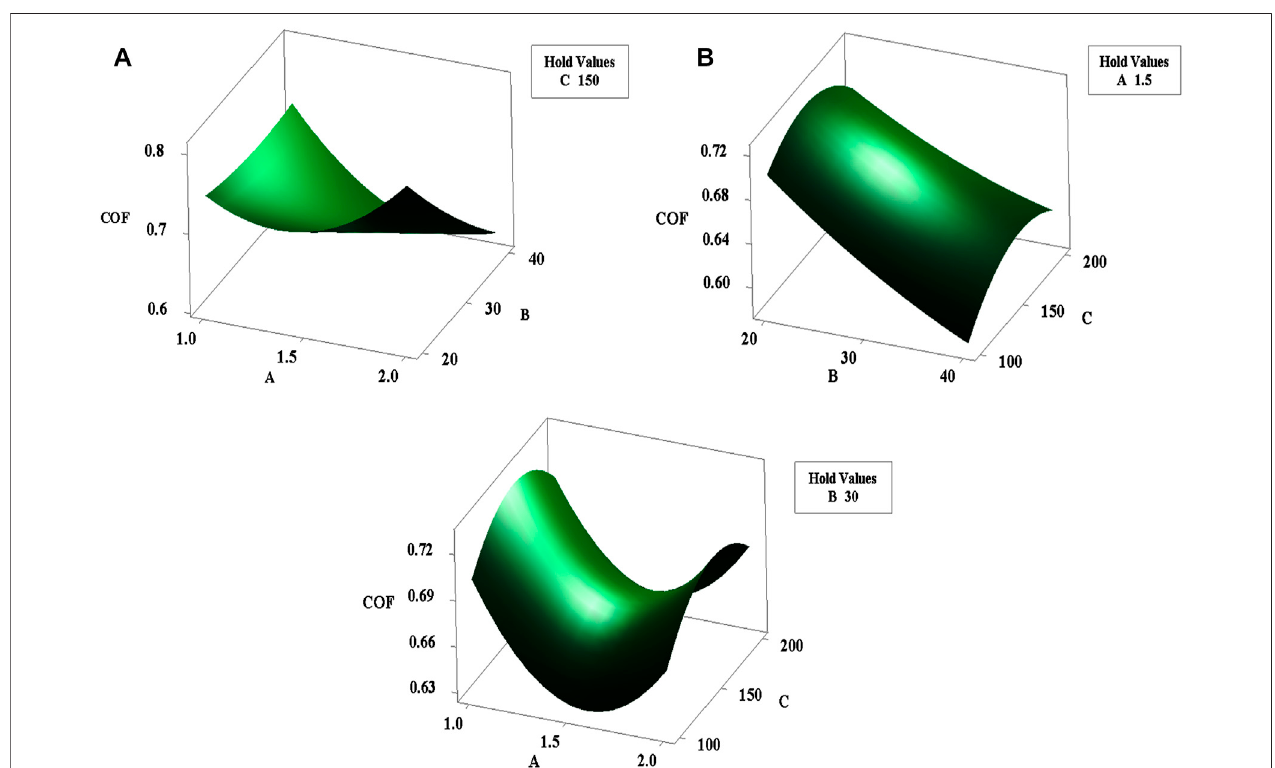
FIGURE 7 | Surface plots of COF vs interacting parameters (A) A × B, (B) B × C and (C) C ×